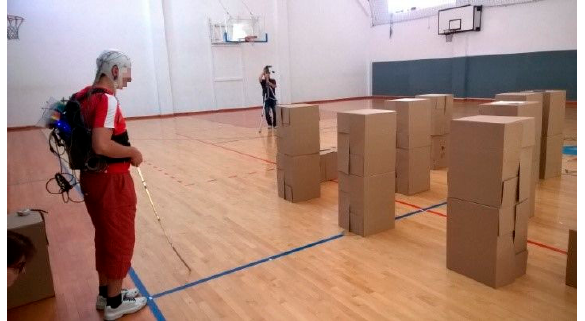
Figure 3. Treasure hunt in a virtual training environment (VTE).